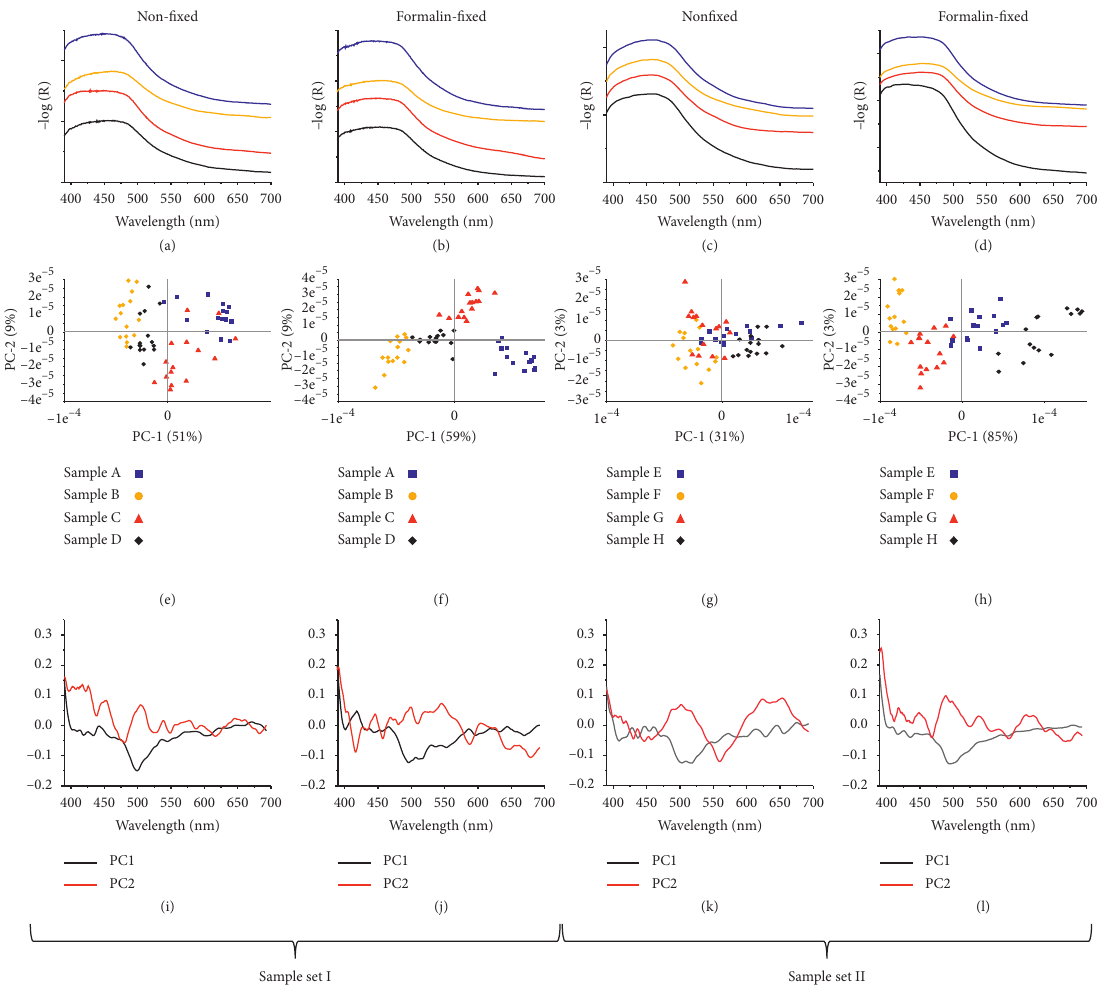
Figure 3: ELS mean spectra and corresponding PCA models: ELS mean spectra of nonfixed (a, c) and formalin-fixed (b, d) brain tumour tissue cross sections in the VIS from 380nm to 700nm. The spectra are vertically displaced and area normalized. (e, g) Scores plot with PC1 versus PC2 to differentiate between nonfixed tissue samples. (f, h) Scores plot with PC1 versus PC2 to differentiate between formalin-fixed tissue samples. The representative tumour entities for the tissue samples A to D with different malignancies are fibrous meningioma (sample (A)), oligodendroglioma (sample (B)), anaplastic ependymoma (sample (C)), and glioblastoma (sample (D)). The representative tumour entities for the tissue samples E to H with different malignancies are plexus papilloma (sample (E)), oligodendroglioma (sample (F)), anaplastic oligodendroglioma (sample (G)), and glioblastoma (sample (H)). Corresponding loadings plots of PC1 (black) and PC2 (red) for nonfixed (i, k) and formalin-fixed (j, l) cross